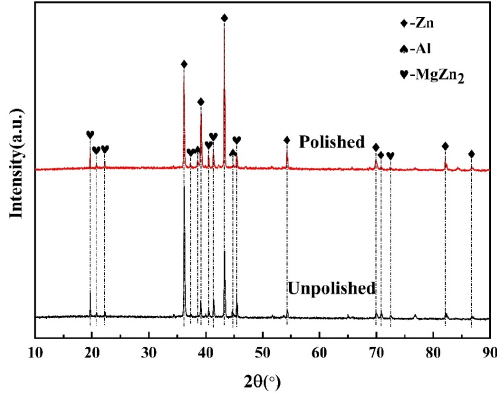
Figure 6. XRD pattern of two groups of coatings.